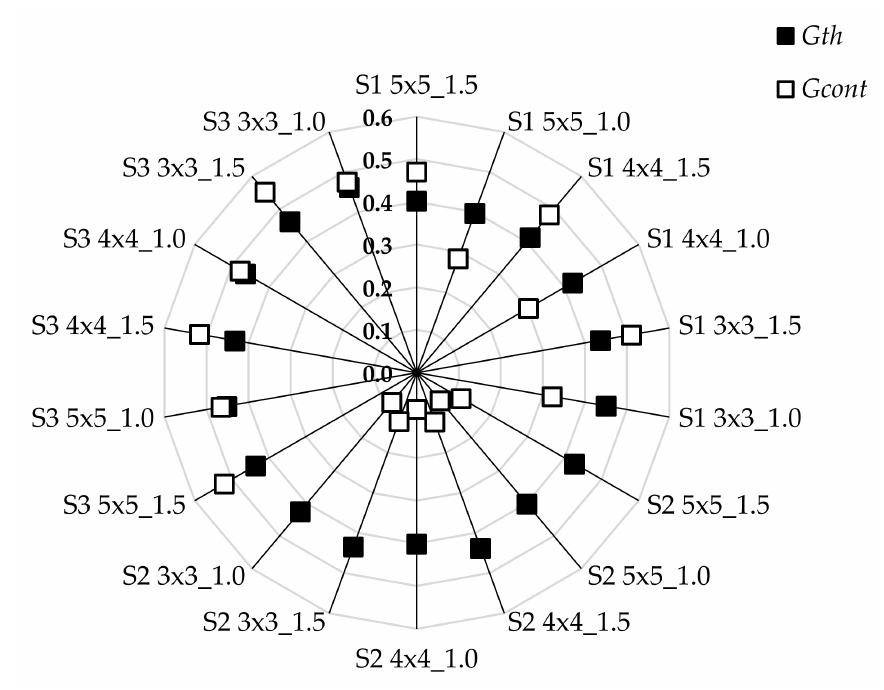
Figure 6. Connectedness of strips’ and strip contacts’ phases.